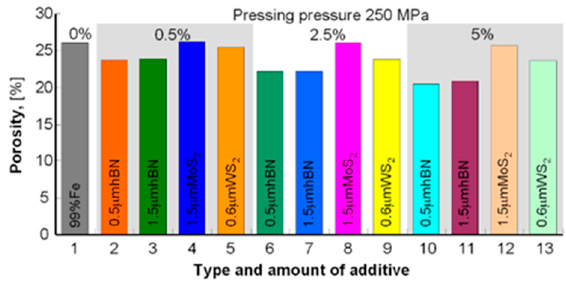
Figure 4. Sample porosity after pressing 250 MPa and sintering.